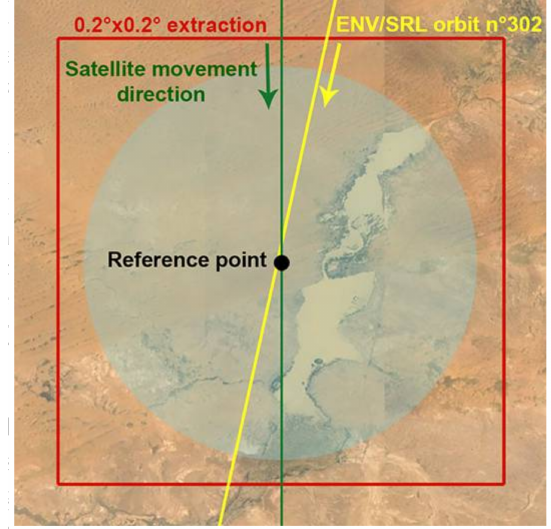
Figure A3. Example of a scene using ASTER GDEM data centered close to the Gossi pond in Mali. The real altimeter satellite path 0302 of ENVISAT RA-2 is represented in yellow, and the simulated orbit (green), along with the reference point of the simulation. The shadowed area around the reference point corresponds to the Ku-band footprint of ENVISAT RA-2.